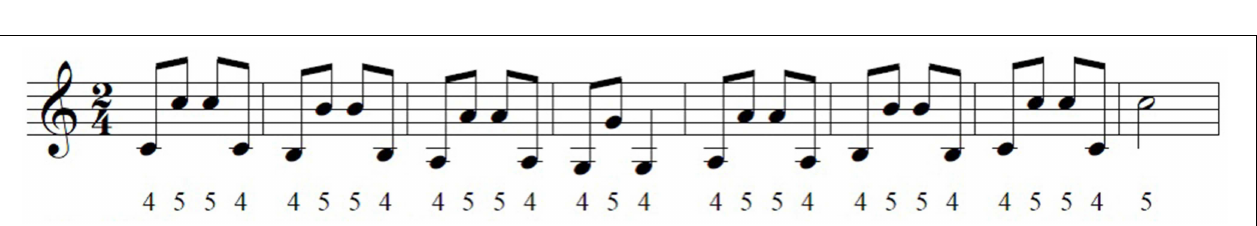
FIGURE 2 | The small-strong condition (SS): small hand span (i.e., fingers are at their natural resting positions) with only strong fingers, i.e., the thumb (1), index (2) and middle (3) fingers involved.